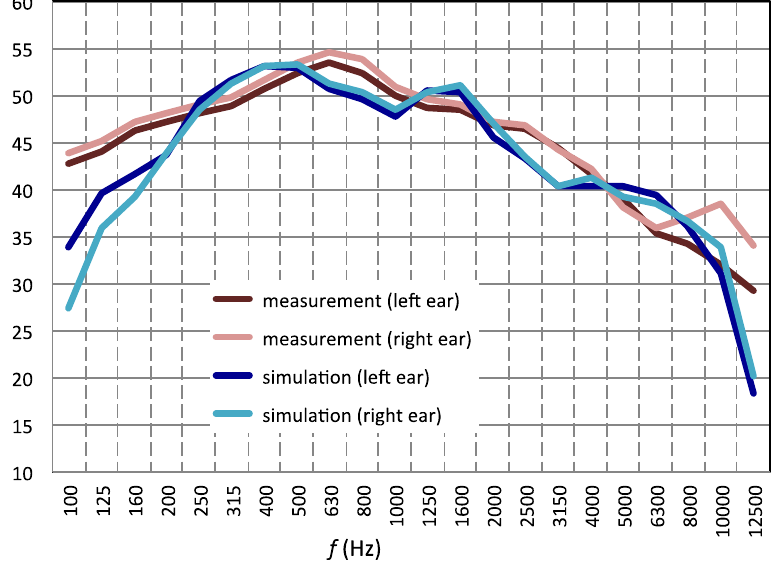
Figure 5. One third of an octave octave spectrum of the sound as measured in the square for the left (dark red) and right (light red) ear of the binaural microphone and simulated virtual environment for left and (dark blue) and right ear (light blue).